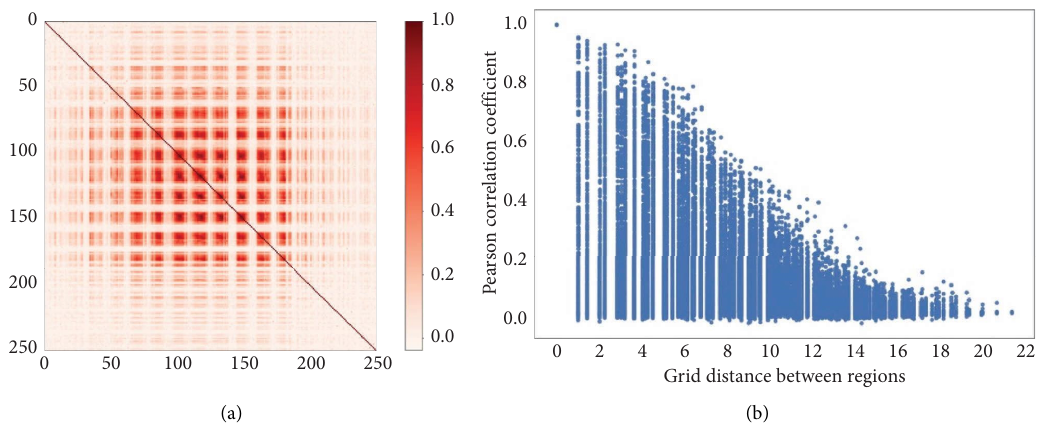
Figure 6: Te analysis of the spatial correlations among regions. (a) Te pairwise Pearson correlation coefcient between regions. (b) Te relationship between the grid distance and the Pearson correlation